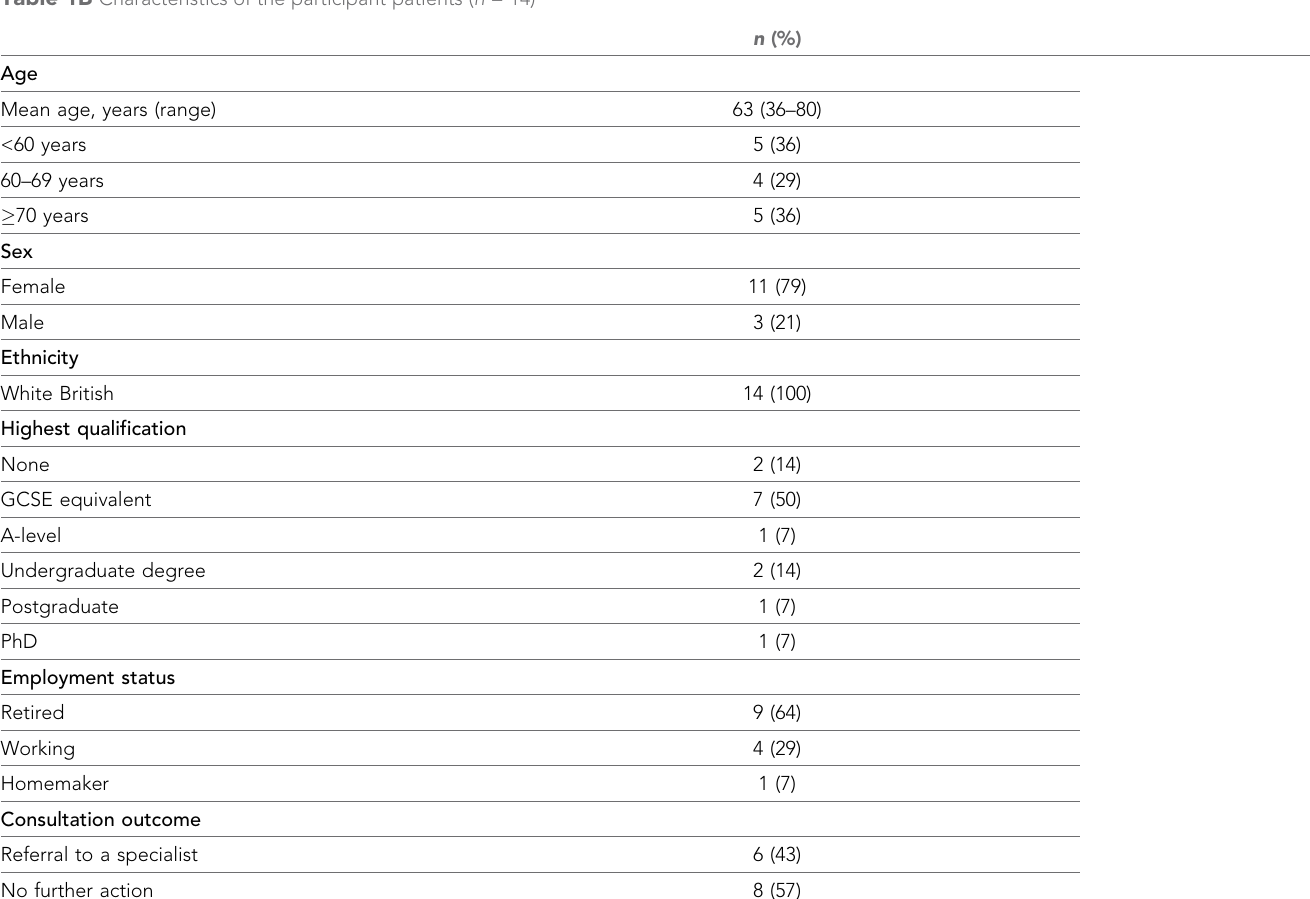
Table 1B Characteristics of the participant patients ( n =